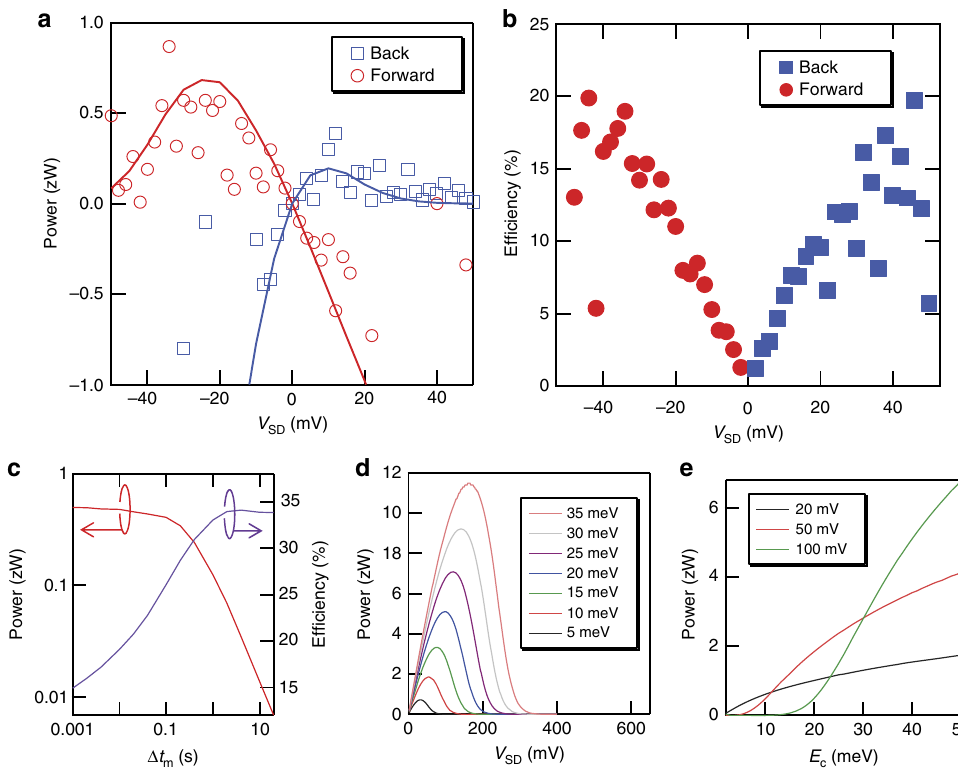
Figure 4 | Power generation by the demon. All voltages are the same as in the case in Fig. 3. ( a ) Generated power as a function of V D . The solid lines are data obtained from Monte-Carlo simulation. ( b ) Efficiency of information-to-energy conversion as a function of V SD . ( c ) D t m dependence of the power and efficiency in Monte-Carlo simulation. ( d , e ) Numerical calculations of power generated by Maxwell’s demon. Generated power as a function of ( d ) V SD at various E C and ( e ) E C at various V SD . For all calculations, k B T ¼ 26meV, G 1 ¼ 1s (cid:3) 1 , G 2 ¼ 10 (cid:3) 10 s (cid:3) 1 and D n ¼ 1 (Supplementary Note